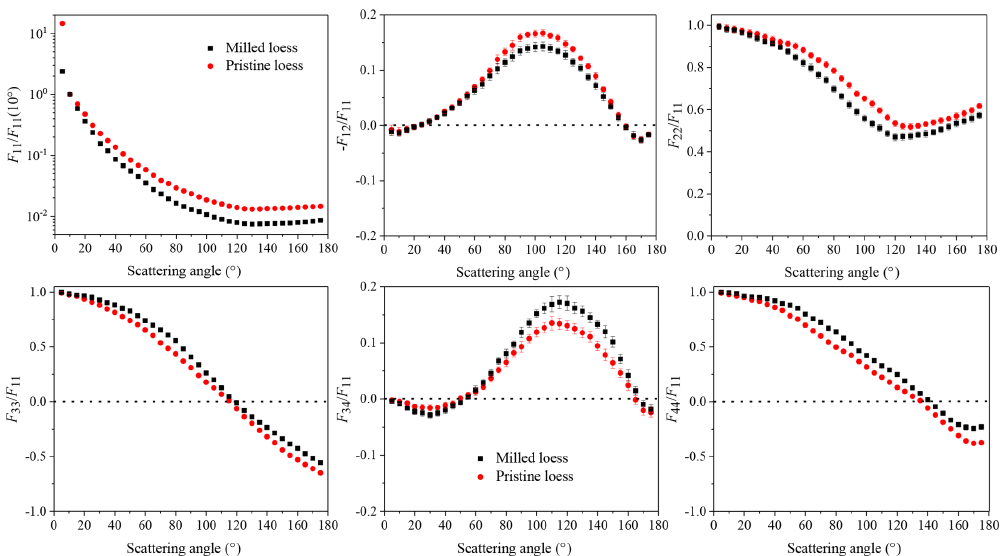
Figure 4. Measured nonzero scattering matrices for pristine loess and milled loess. It should be noted that milled loess is the same sample as the Luochuan loess in Liu et al.